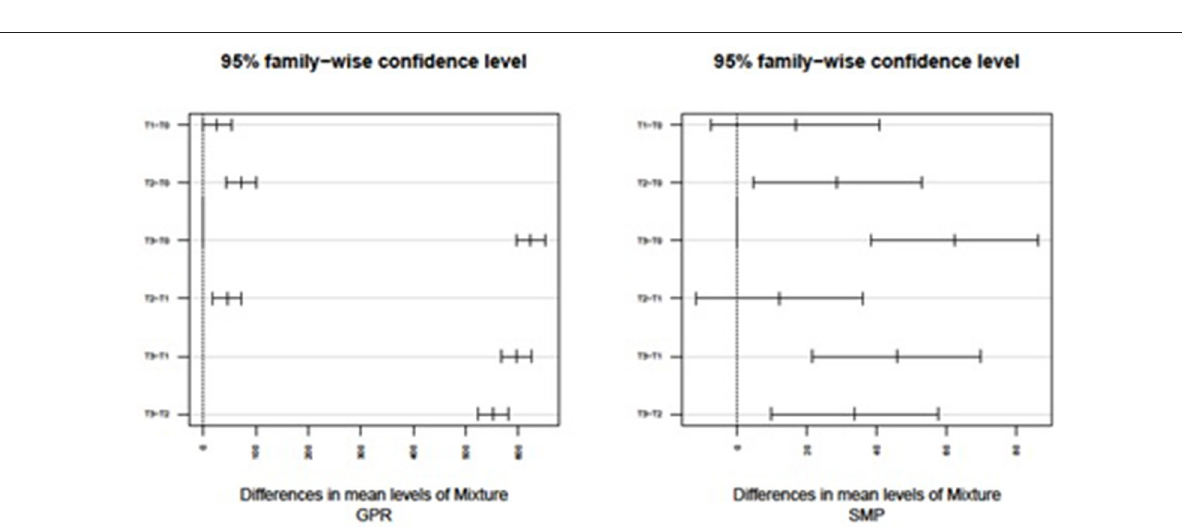
Frontiers in Sustainable Food Systems |